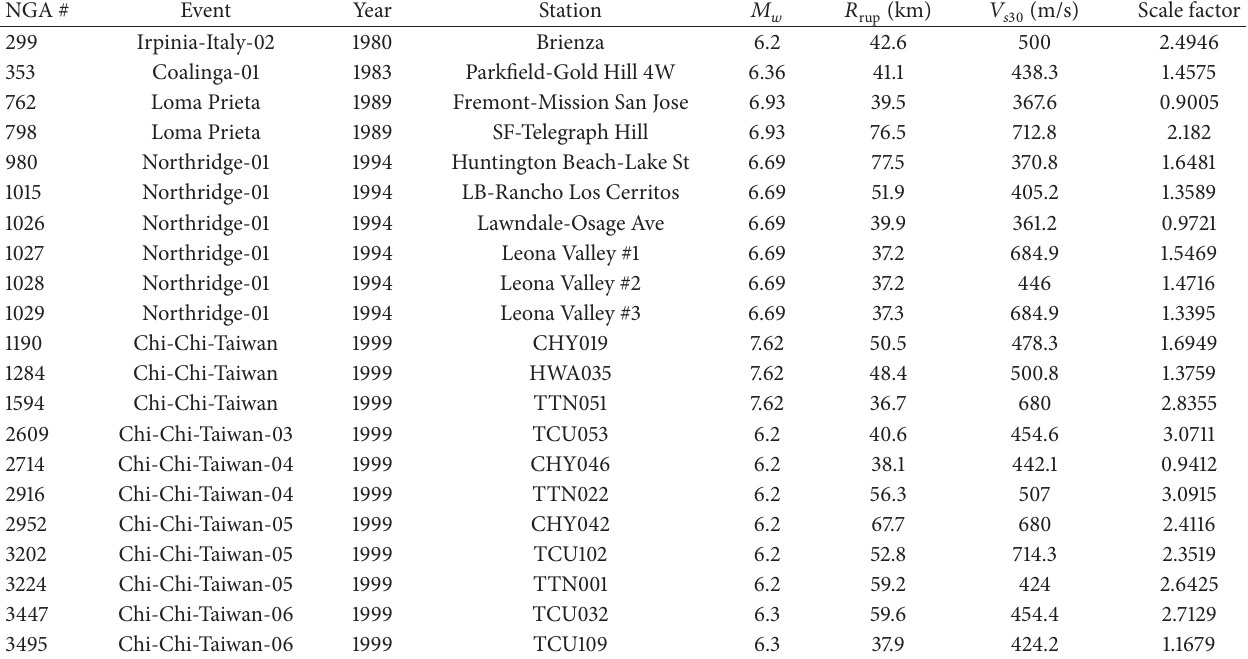
Table 3: Selected ground motion records for site class